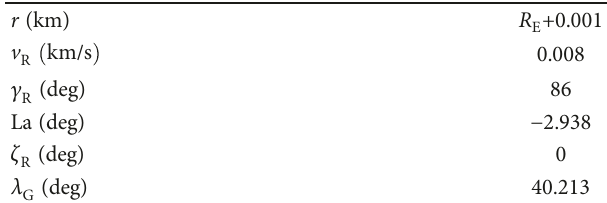
Table 4: Initial condition for (22).